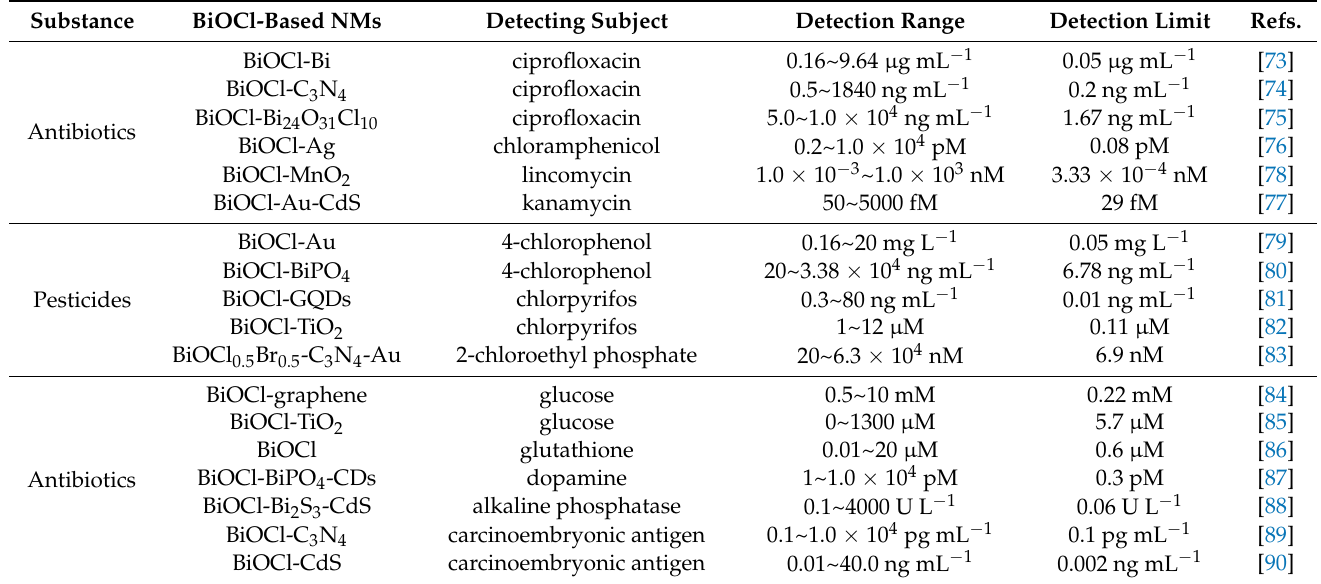
Table 2. BiOCl-based NMs used as photoelectrochemical sensing